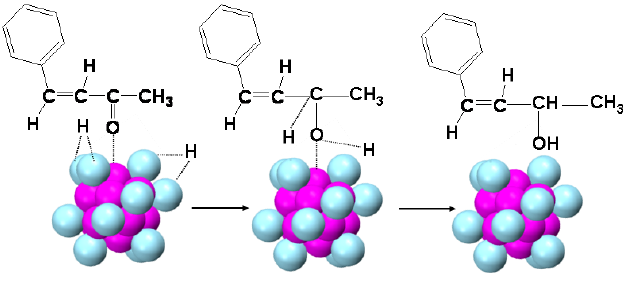
Figure 13 ． Proposed mechanism of Au hydrogenation of α , β -unsaturated ketone to unsaturated alcohol (pink: Au atoms of the core, blue: Au atoms of the shell